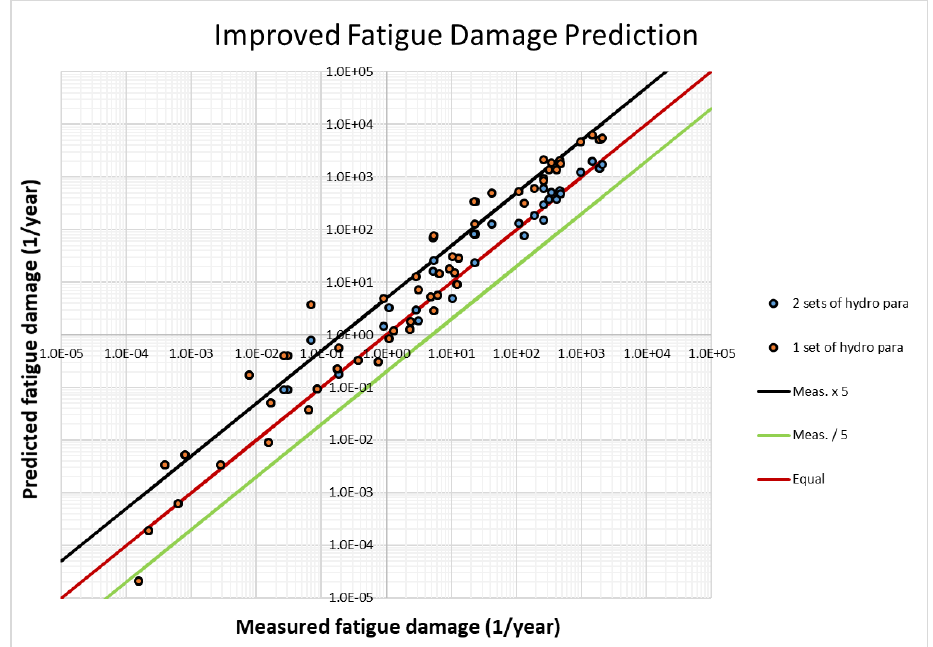
Figure 10. Comparison of the predicted fatigue relative to the measured fatigue when predicted using one or two optimal sets of hydrodynamic parameters. The deviation between the predictions and measurements is clearly smaller when using two sets with the allocation of parameters based on the clustering